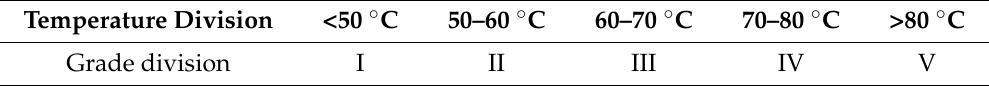
Table 3. Classification of temperature risk grade in the dust collector box.